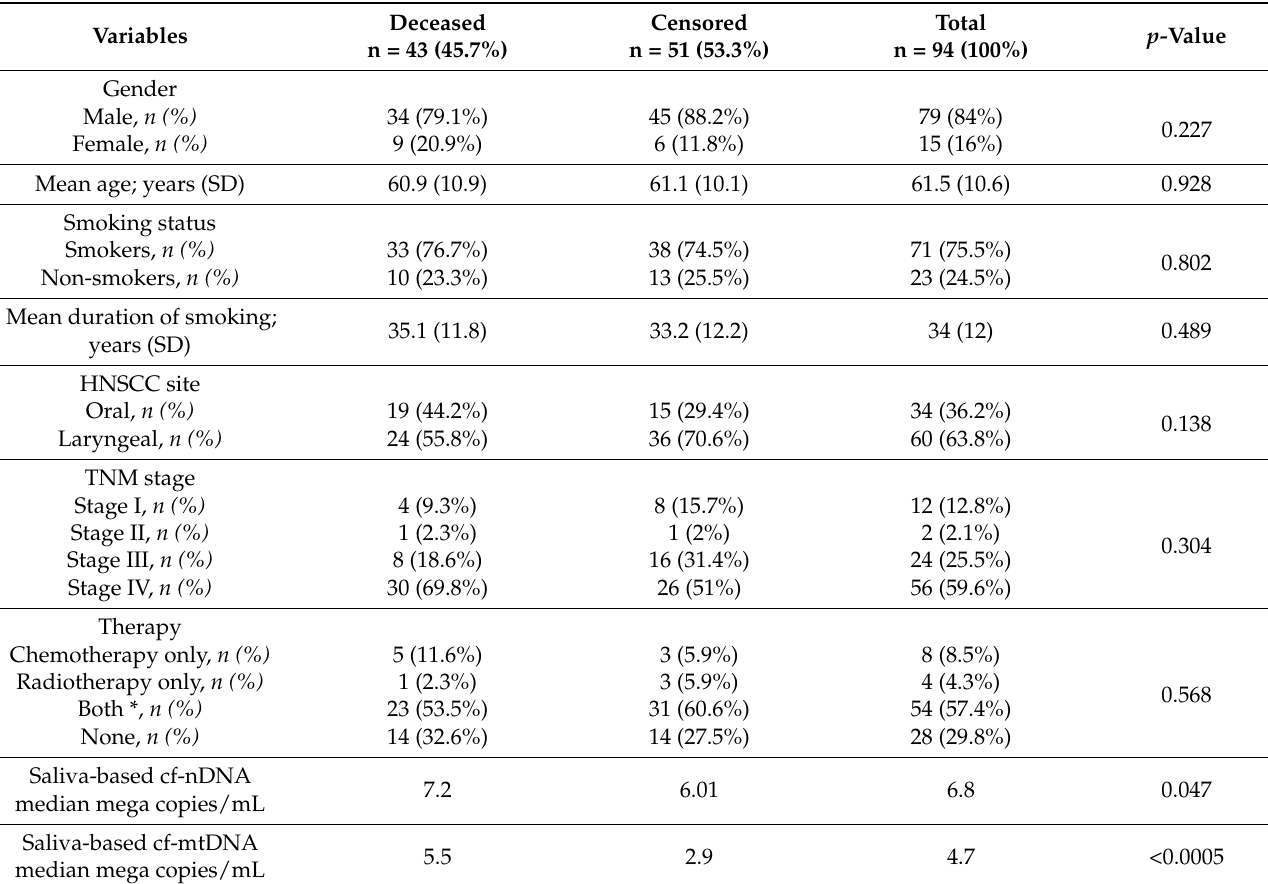
Table 2. Main characteristics of the study variables at the end of the follow-up time and associations with patient status (deceased and